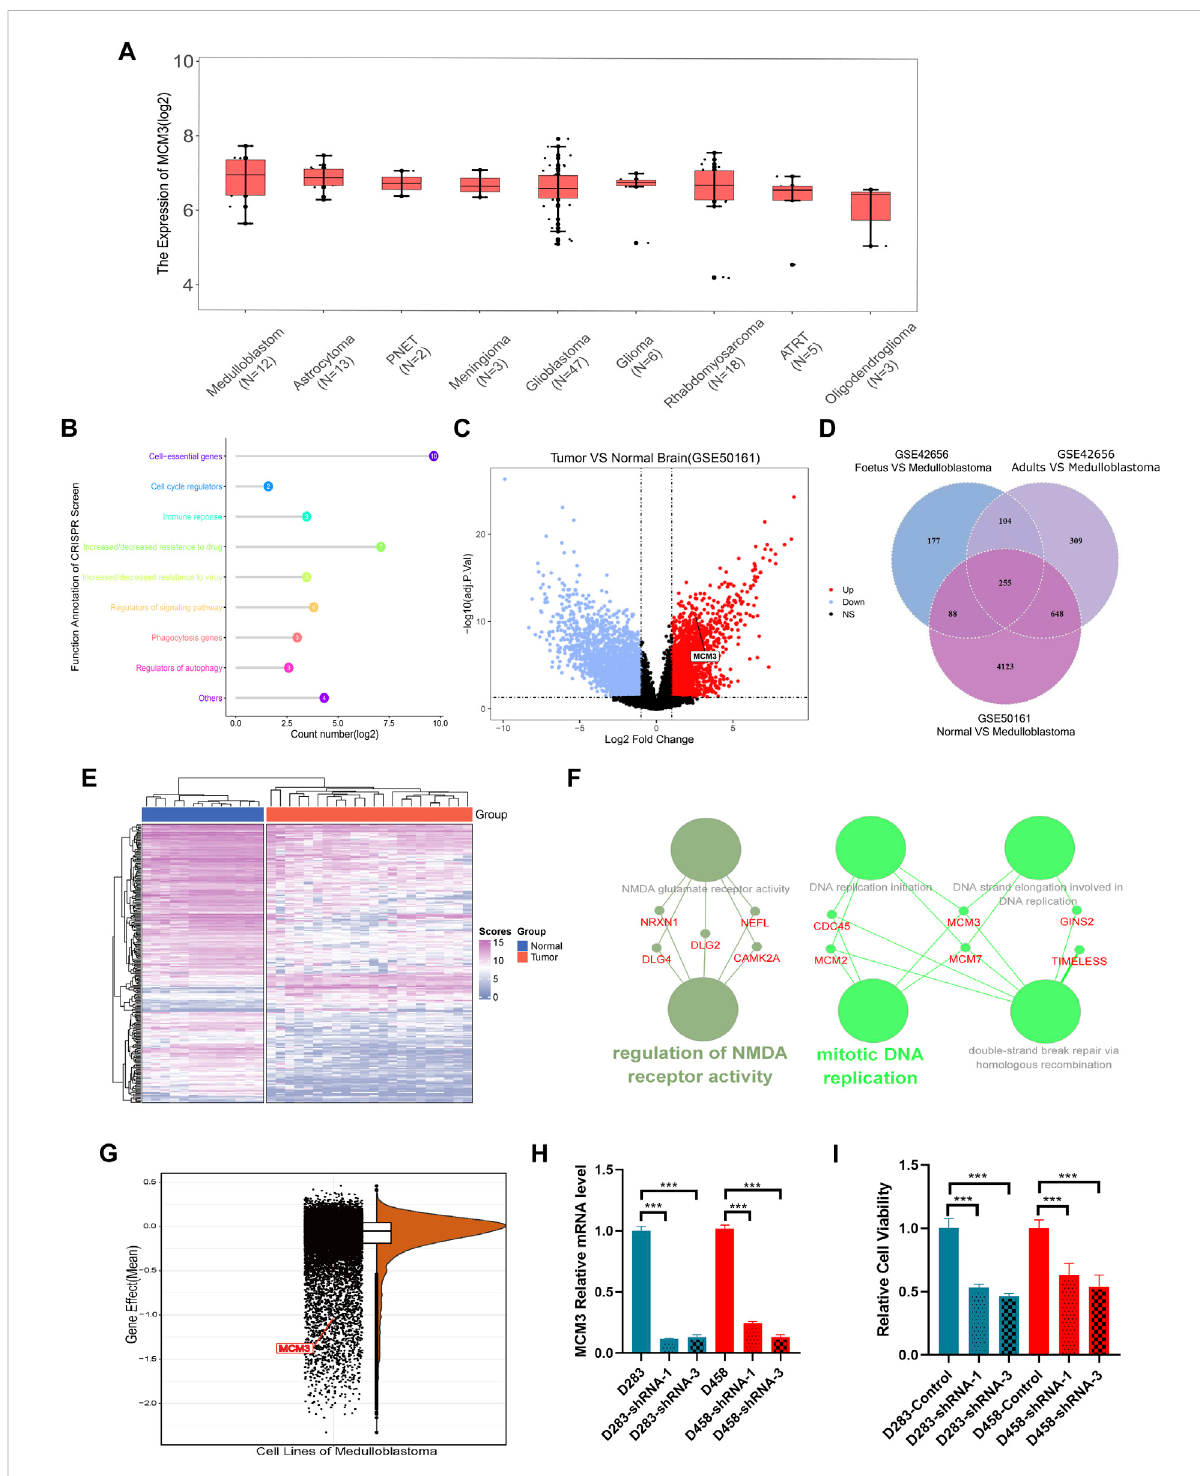
FIGURE 1 MCM3 expression levels among brain tumor cell lines (A) . Functional annotation of MCM3 from the BioGRID ORCS database by CRISPR (B) . MCM3 upregulation in the tumor group of GSE50161 (C) . 255 DEGs showed dysregulation in the three contrast sets (D) . The normal and medulloblastomasamplesfromGSE50161clusteredrespectivelyaccordingtotheexpressionofDEGs (E) .Hubgenesanalysis via Cytoscapeshowing the main biological functions with which MCM3 is involved (F) . Gene effects (namely the dependency of the cell on genes) of MCM3 re fl ect its essentiality for cancer cell survival (G) . Con fi rmation of MCM3 knockdown by shRNA-1 and shRNA-3 on RNA level by QT-PCR (H) in both D283 and D458 cell lines (H) . Signi fi cantly decreased cell viability in sh-MCM3 cell lines (I)